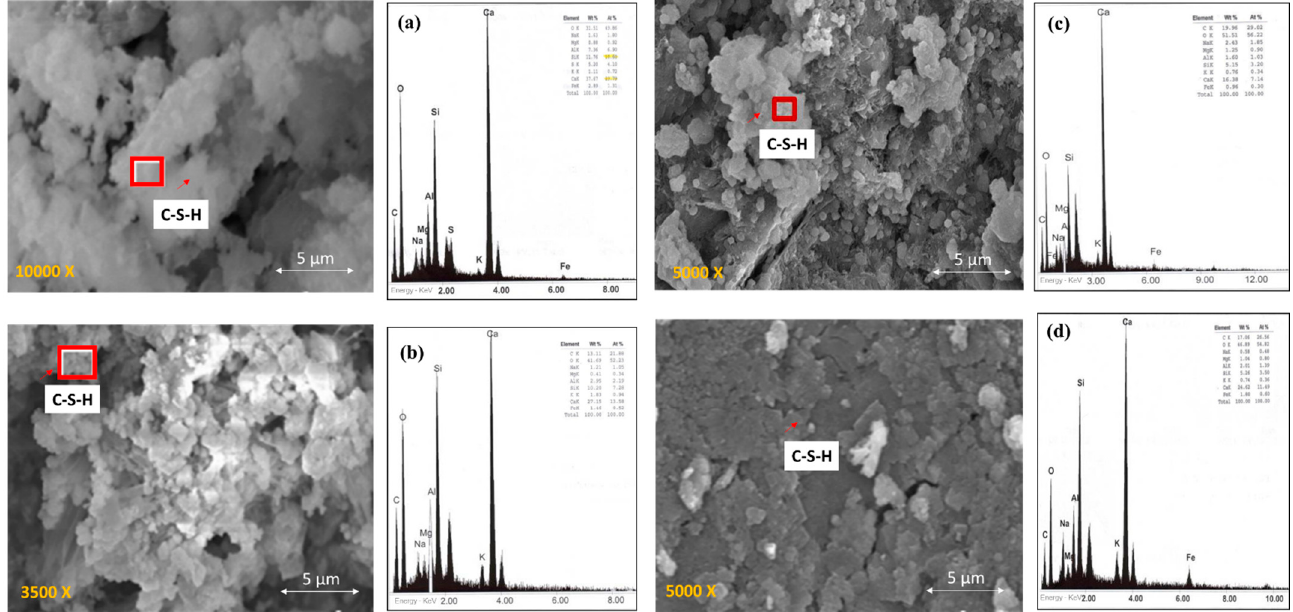
Figure 2. SEM surface morphology micrographs and elemental analysis by X-ray dispersive energy spectroscopy (EDS) of specimens made with the OPC mixture: ( a ) 2OPC-P Ca/Si = 2.24, ( b ) 2OPC-OP Ca/Si = 1.86, ( c ) 3OPC-P Ca/Si = 2.23, ( d ) 3OPC-OP Ca/Si = 3.25.